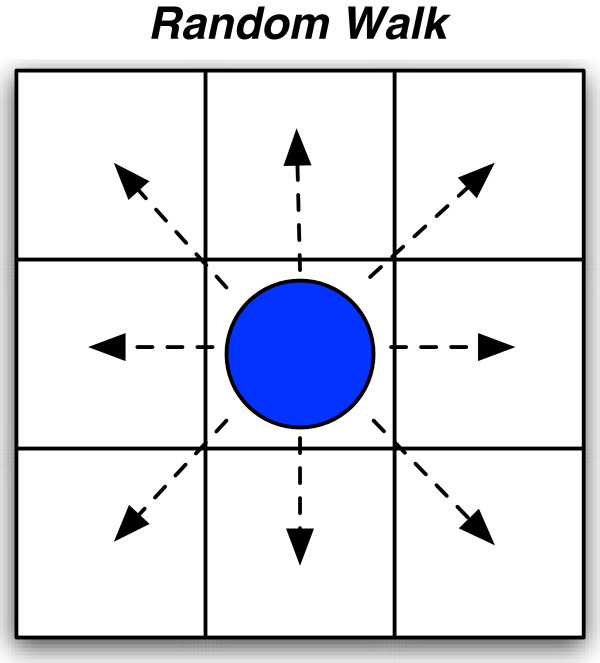
Agent movement follows random walk. Movement of agents based on Brownian motion and simulated by a random walk. An agent will randomly select an adjacent cell and move to that new location.